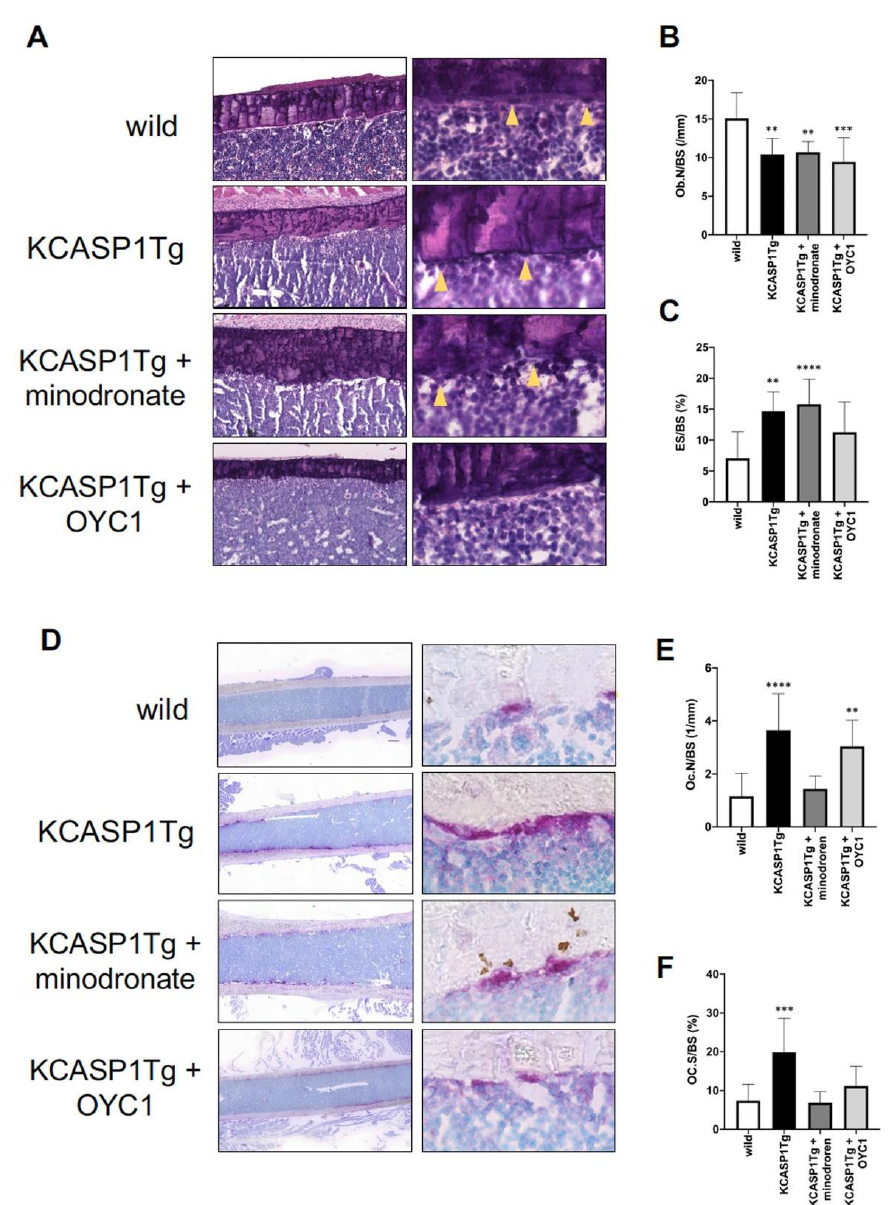
Figure 5. Histomorphometric evaluation by HE and TRAP staining. HE staining (left panel × 100 and right panel × 400) of the femoral diaphysis in wild-type, KCASP1Tg, and treated KCASP1Tg mice ( A ). The number of osteoblasts per bone surface (Ob.N / BS) was significantly decreased ( B ) and the eroded surface per bone surface (ES / BS) was increased in KCASP1Tg mice compared to wild-type littermates. ES / BS was not improved in both minodronate- and OYC1-treated KCASP1Tg mice ( C ). Ob.N / BS and ES / BS were quantified in three random parts of the HE section in each sample ( × 100, n = 3). TRAP staining (left panel scale bar is 300 µ m, right panel × 400) of the femoral diaphysis in wild-type, KCASP1Tg, and treated KCASP1Tg mice ( D ). Osteoclast number per bone surface (Oc.N / BS, ( E )) and osteoclast surface per bone surface (Oc.S / BS, ( F )) were analyzed in three random parts of the TRAP section in each sample ( × 100, n = 3). Oc.N / BS and Oc.S / BS were significantly increased in KCASP1Tg mice compared to wild-type mice. Minodronate treatment reduced both Oc.N / BS and Oc.S / BS, whereas OYC1 ameliorated only Oc.S / BS ( E,F ). All data are expressed as mean ± SD. *; p < 0.05, **; p < 0.01, ***; p < 0.001, ****; p < 0.0001 compared to KCASP1Tg mice by Mann–Whitney